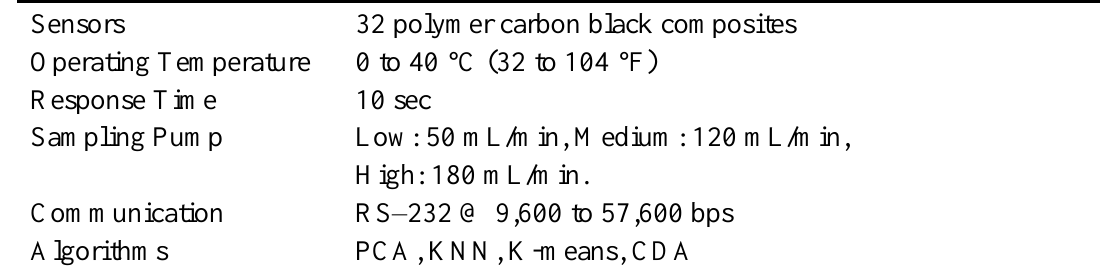
Table 1. Important features of the Cyranose 320